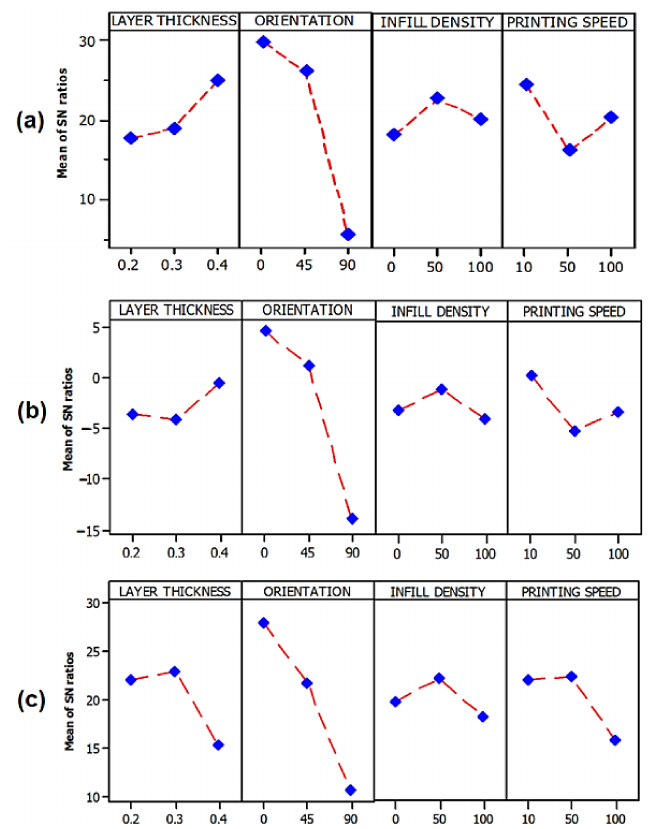
Figure 8. Main effects plot for the S/N ratios (larger the better) of ( a ) tensile strength ( b ) Young’s modulus and ( c ) flexural